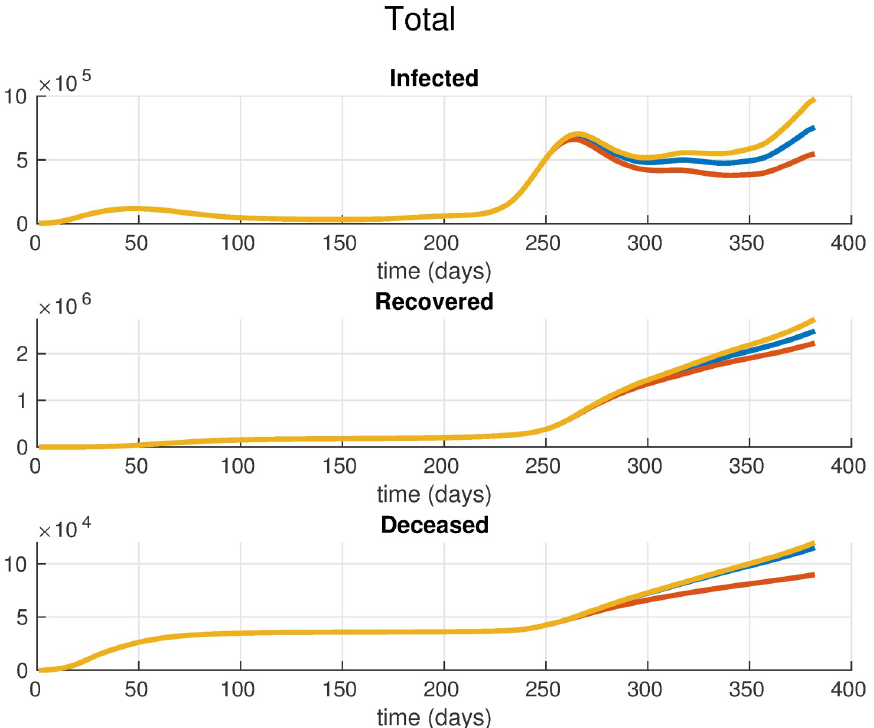
Fig 6. Multi-simulation prediction of the overall population. The blue curve corresponds to the case of a uniform lockdown obtained using the parameters � θ � estimated from the actual data, the red curve corresponds to the case of a strengthened lockdown for the eldest age classes, and the yellow curve corresponds to the case of a relaxed lockdown for the youngest age classes. The selective restrictions start at day 250.